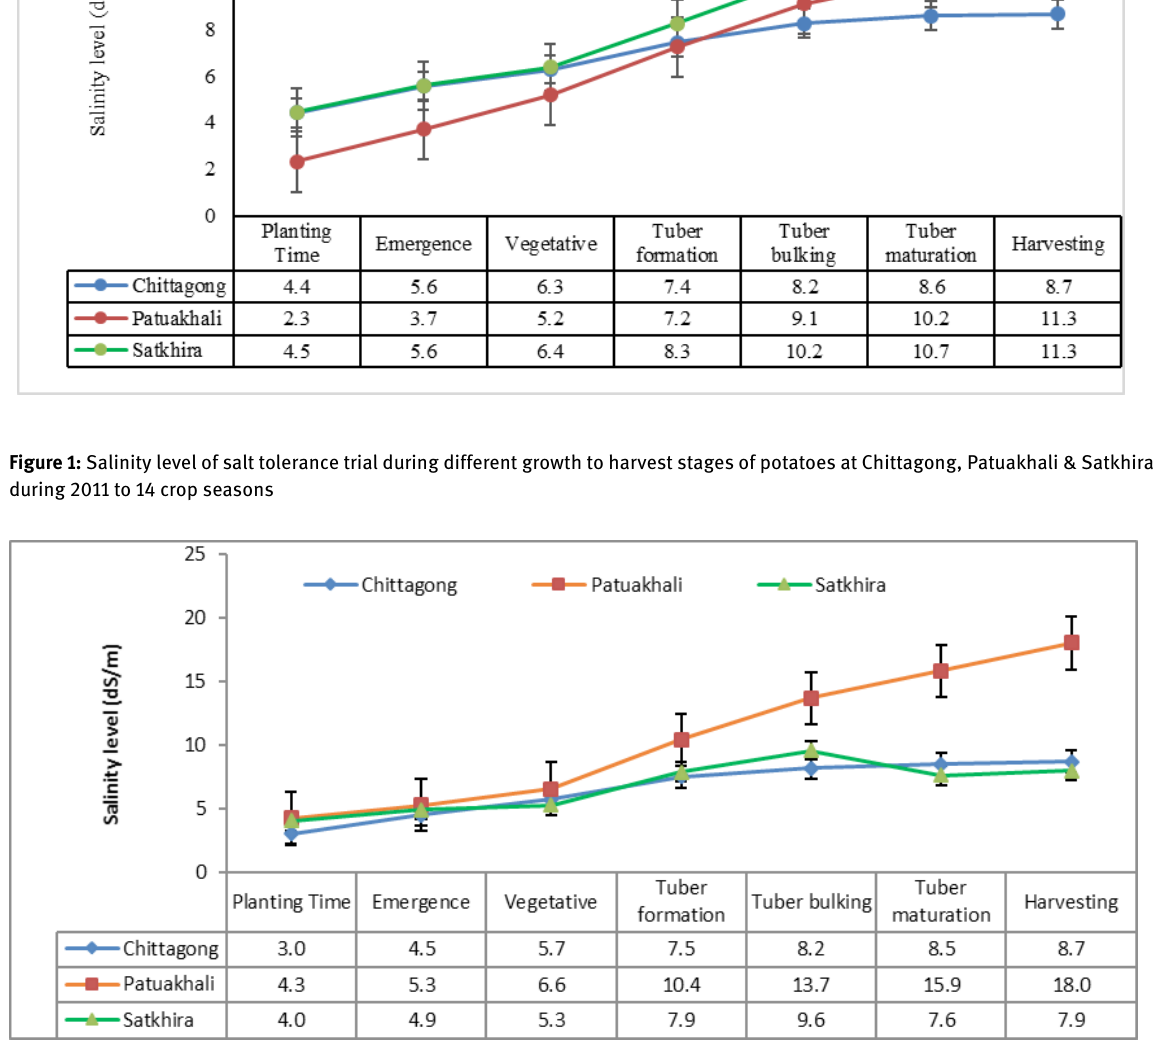
Figure 2: Salinity level of salt tolerance trial during different growth to harvest stages of potatoes at Chittagong, Patuakhali & Satkhira during 2014-15 crop